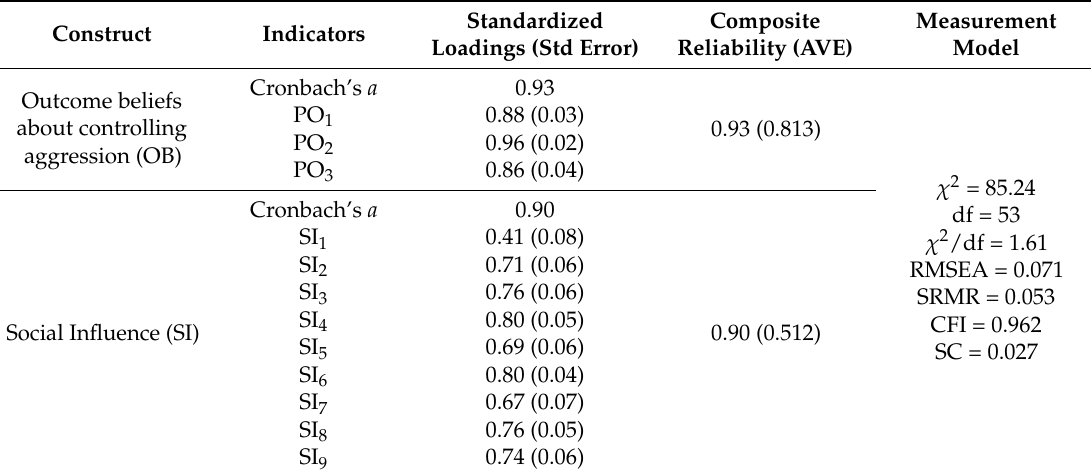
Table 4. Reliability of the standardized confirmatory factor